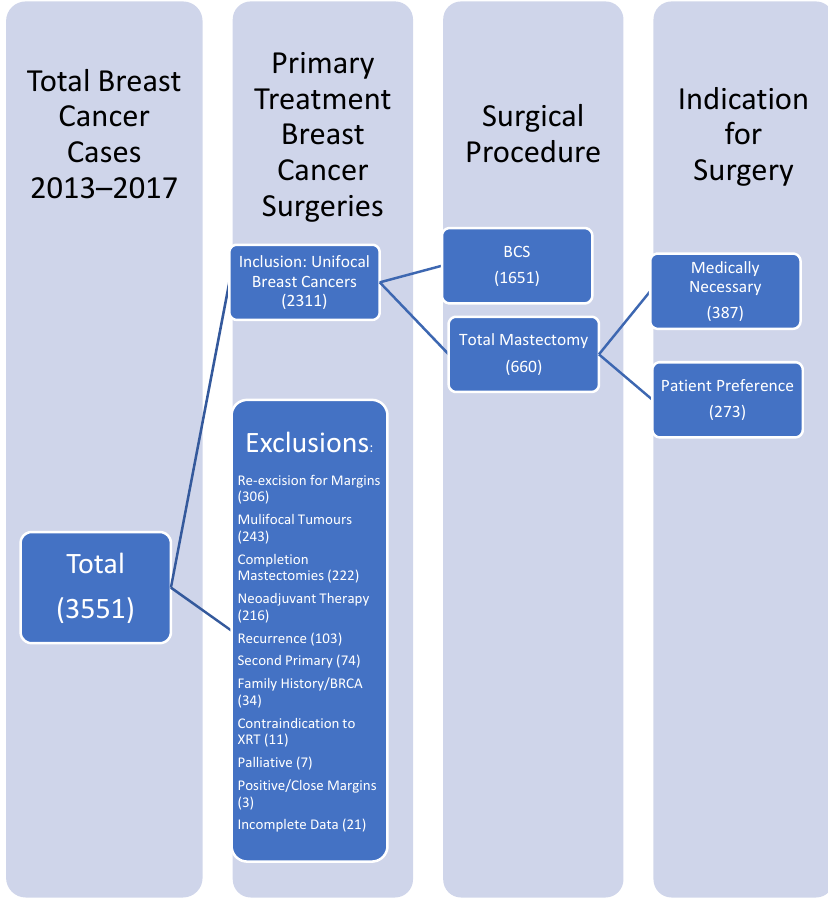
Figure 1. Overview of breast cancer surgeries performed.